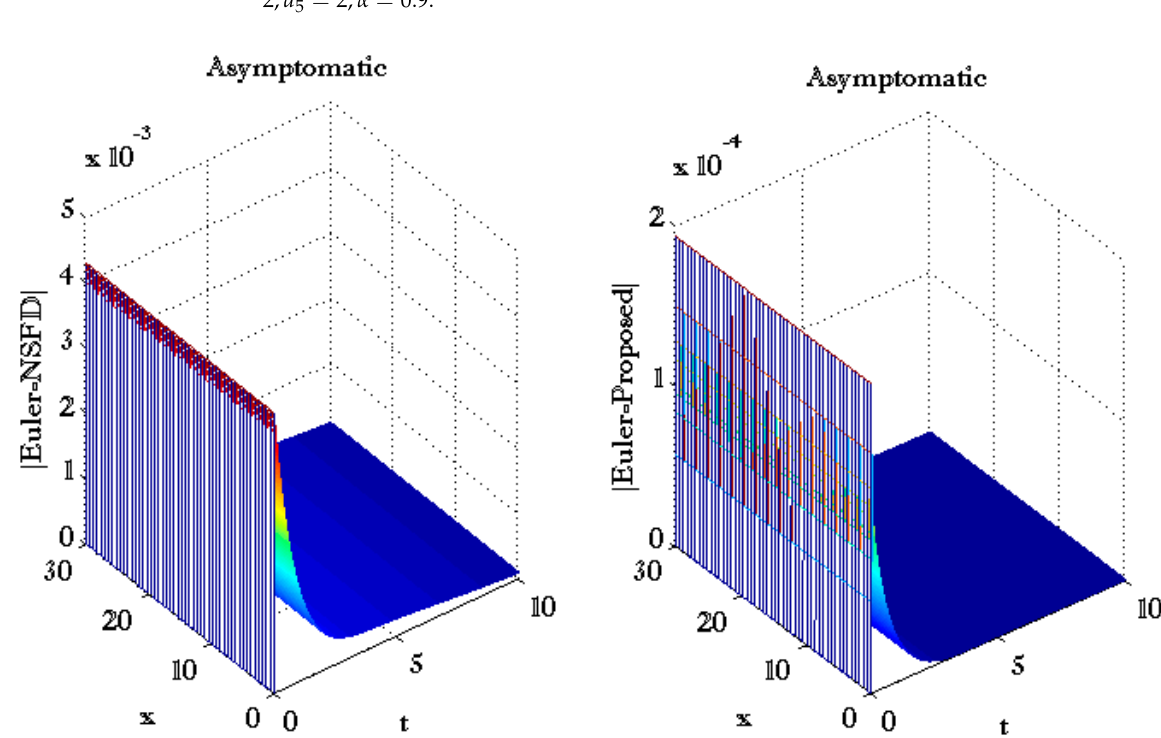
Figure 6. Three-dimensional comparisons of proposed and NSFD schemes for asymptomatic indi- viduals using N x = 50, N t = 1300, α 1 = 0.1, β = 0.1, γ = 0.3, σ = 0.4, µ = 0.5, d 1 = 2, d 2 = 2.5, d 3 = 2.5, d 4 = 2, d 5 = 2, α = 0.9 .